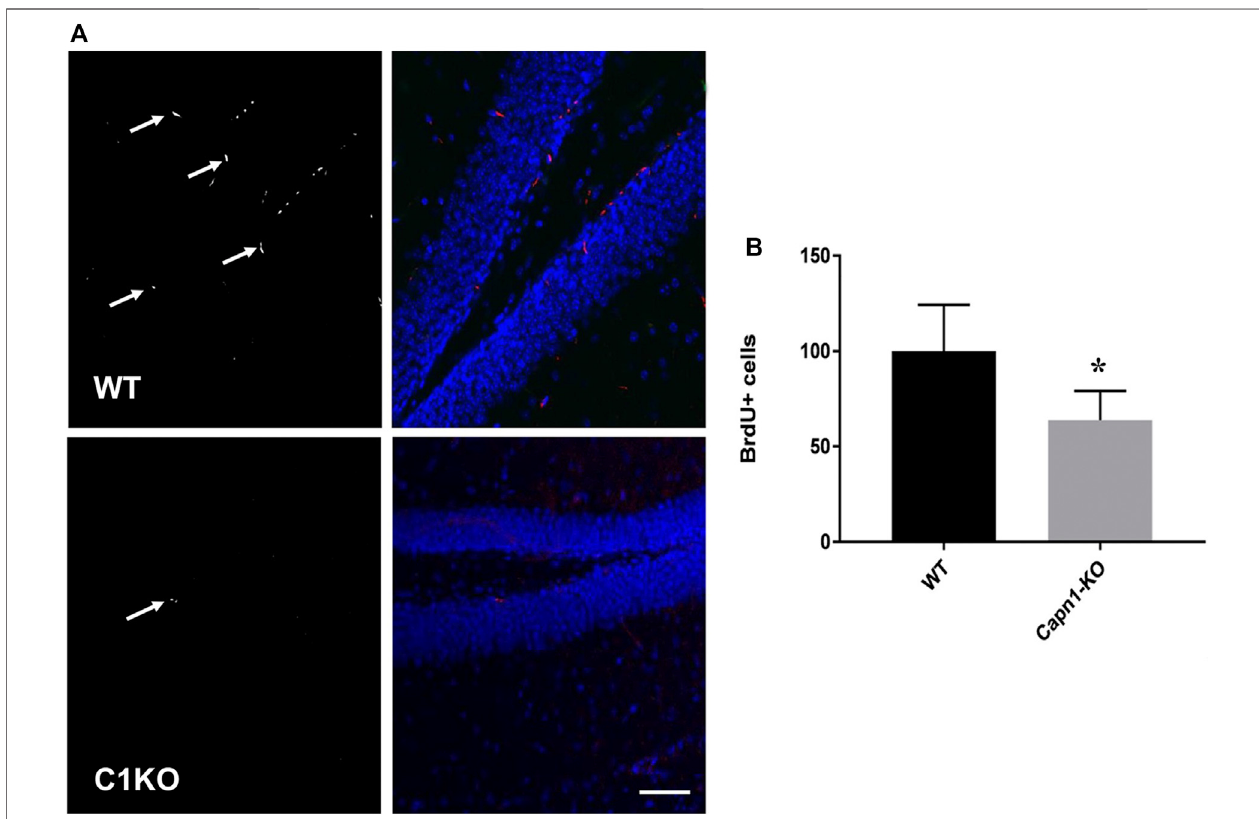
FIGURE 1 | BrdU+ cells in the dentate gyrus of WT and C1KO mice. WT and C1KO mice were injected i.p. with 5-bromo-2-deoxyuridine (BrdU) (50 mg/kg) every 8 hfor3 days,foratotalofnineinjections. Brainswerecollectedfollowingtranscardialperfusion 3 daysafter the fi rstBrdUinjection. Brains weresectioned andsections were processed for immunolabeling with antibodies against BrdU (A) , left panels, arrows) and NeuN (A) , right panels, blue). Numbers of BrdU+ cells were quanti fi ed as indicated in the Materials and Methods section (B) . Sections were counterstained with DAPI (blue). Five sections per mouse were quanti fi ed and 5 WT and C1KO mice were analyzed. Results are expressed as percent of the average number of cells in the WT mice and are Means ± SEM of 5 mice per group. * p < 0.01, Student ’ s t-test. Scale bar: 50 µm.